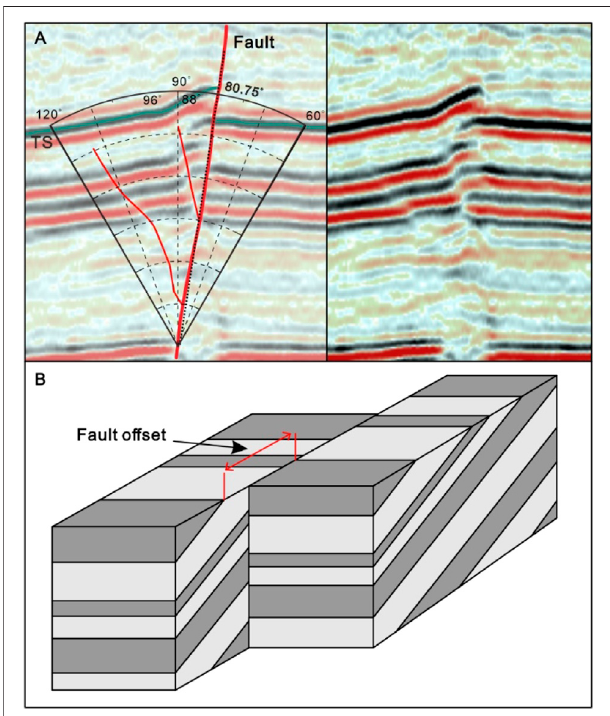
FIGURE 4 | (A) Explanation of the methodology used for the measurement of the Tendency change and (B) a schematic model showing that horizontal displacement of strike slip fault on the horizontal plane or time